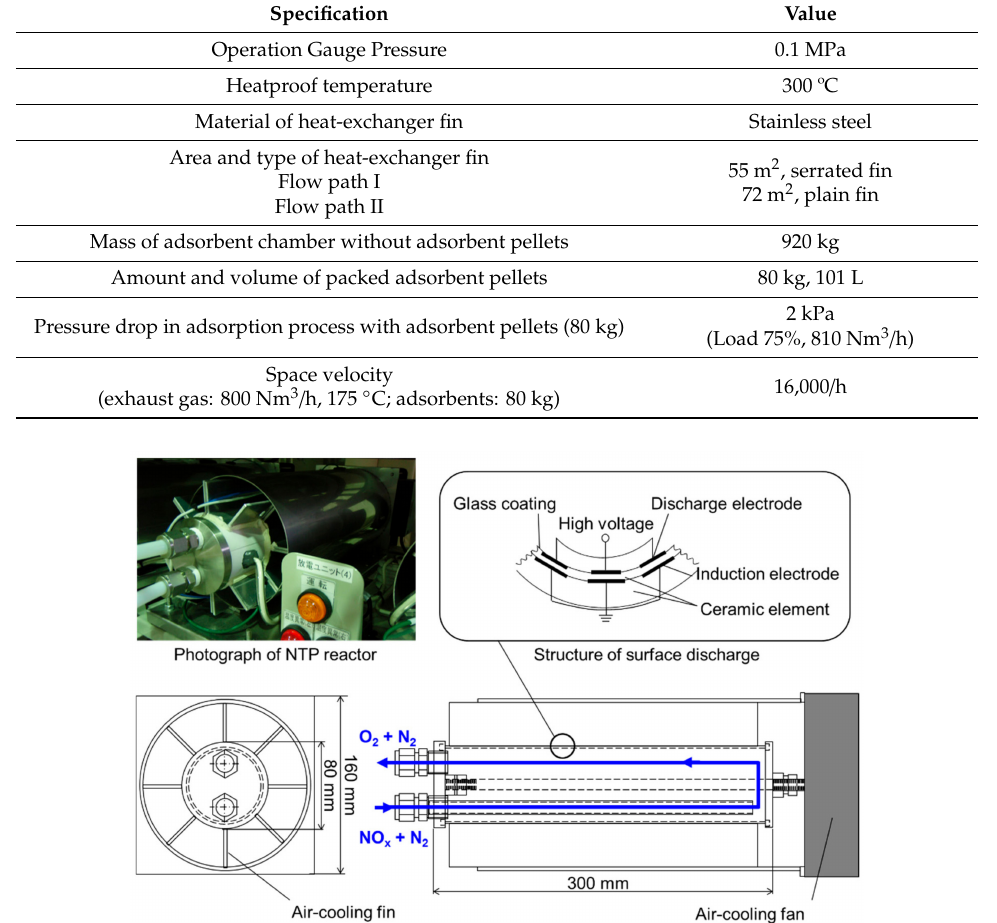
Figure 6. Schematic of the nonthermal plasma (NTP) reactor, showing the structure of the discharge section, along with a photograph of the NTP